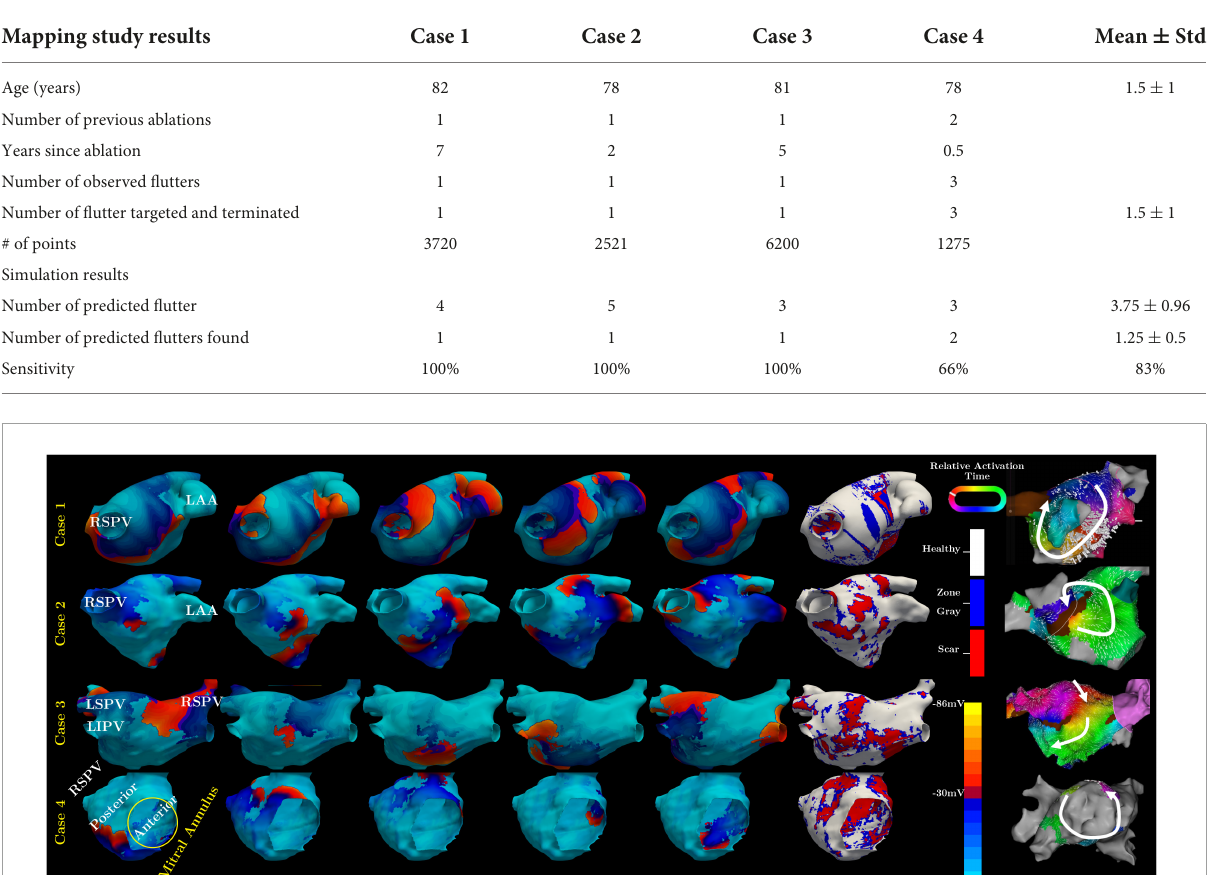
TABLE 2 Simulation and clinical summary.